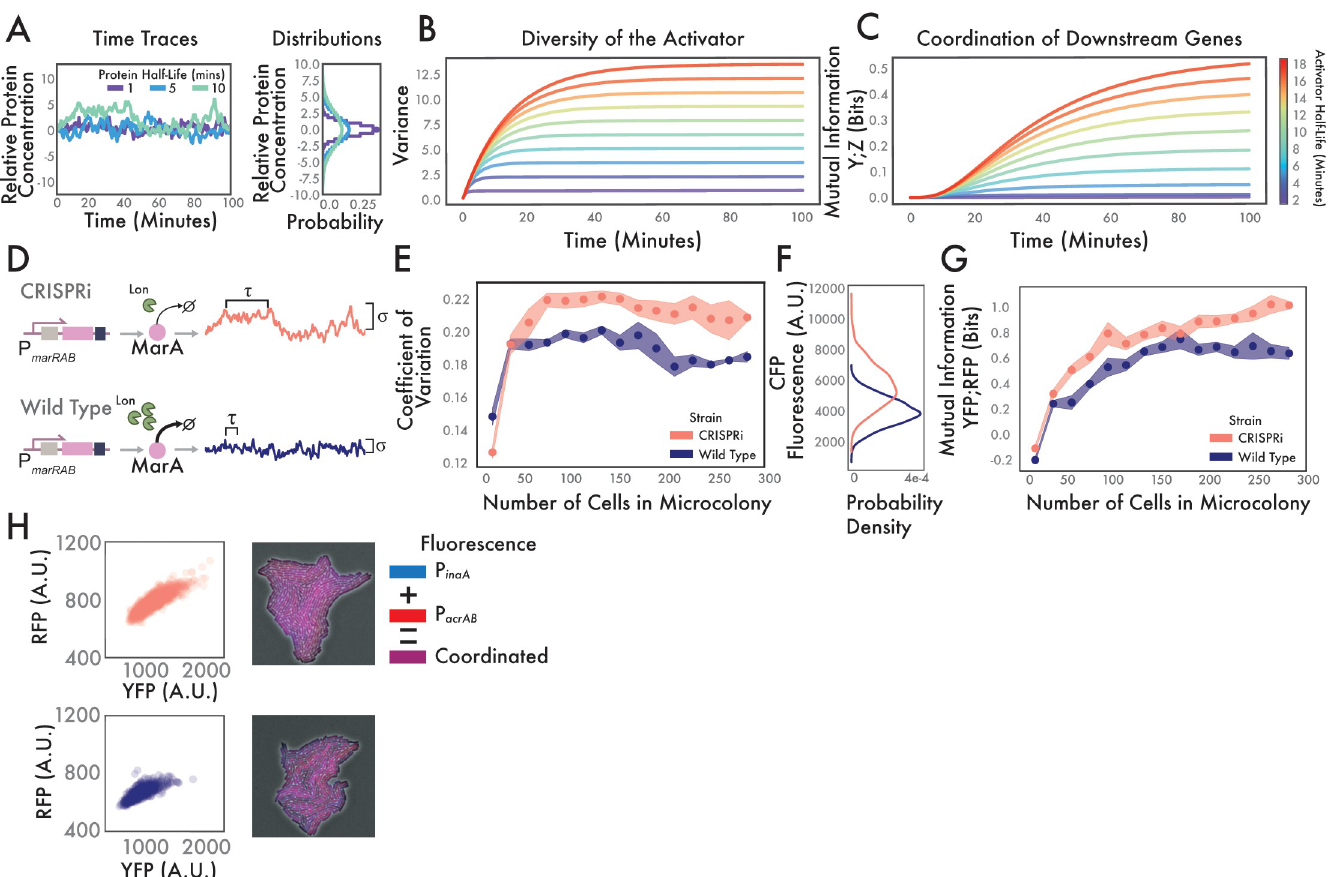
Fig 2. CRISPRi knockdown of Lon protease to increase half-life. (A) Simulation of how the half-life of regulator X affects correlation time and variability. Sample trajectories with varying degradation rates produce different probability distributions (right). Negative and positive values indicate relative changes in concentration compared to the mean. (B) Analytical solutions for the variability of a protein as a function of differing half-lives. Individual traces demonstrate increasing variance as a function of time and the half-life. (C) Analytical solutions for the coordination of two downstream genes as a function of differing activator half-lifes. Individual traces demonstrate increasing coordination in two downstream genes as a function of time and the half-life of the activator. (D) Experimental schematic for CRISPRi knockdown of Lon protease. Upper row shows how time-constant τ and the noise scaling term σ are modified via decreased concentration of Lon protease due to CRISPRi knockdown. Bottom row indicates wild type system where Lon actively degrades MarA, producing time-series changes in protein concentration. (E) Experimental results showing differences in activator variability between wild type and CRISPRi systems. Dots show mean coefficient of variation over n = 5 growing microcolonies. Shaded regions show standard error (S3 Fig). (F) Histograms showing distributions of P marA at final time point of (E). The two distributions are statistically different by the Kolmogorov-Smirnov test, p < 0.001. (G) Downstream coordination expands differently in wild type and CRISPRi strains. Mutual information between YFP and RFP (P inaA and P acrAB ) is calculated across replicates in n = 5 growing microcolonies. Mean and standard error are represented as in (E). (H) Maximum coordinated diversity is increased in CRISPRi system over wild type. Bivariate scatter plots show P inaA and P acrAB expression levels at the final time point across n = 5 microcolonies. The two distributions are statistically different by the 2D Kolmogorov-Smirnov test, p < 0.001. Snapshots give examples of coordination in a single microcolony. Blue is P inaA , red is P acrAB , downstream coordination appears as magenta. Note that lack of coordination appears as red or blue cells.